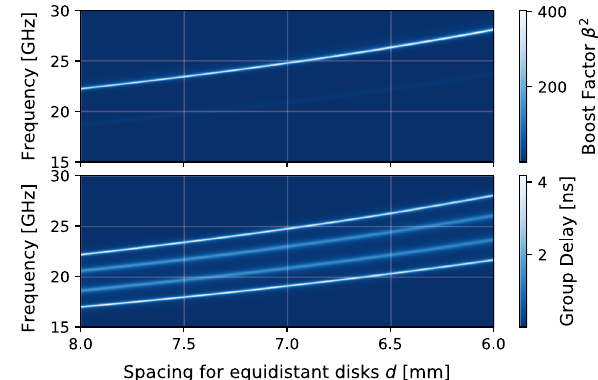
Fig. 8 Simulatedboostfactor(top)andgroupdelay(bottom)asafunc- tion of frequency (vertical axes) and separation between the sapphire disks (horizontal axes) for a system of four equidistant